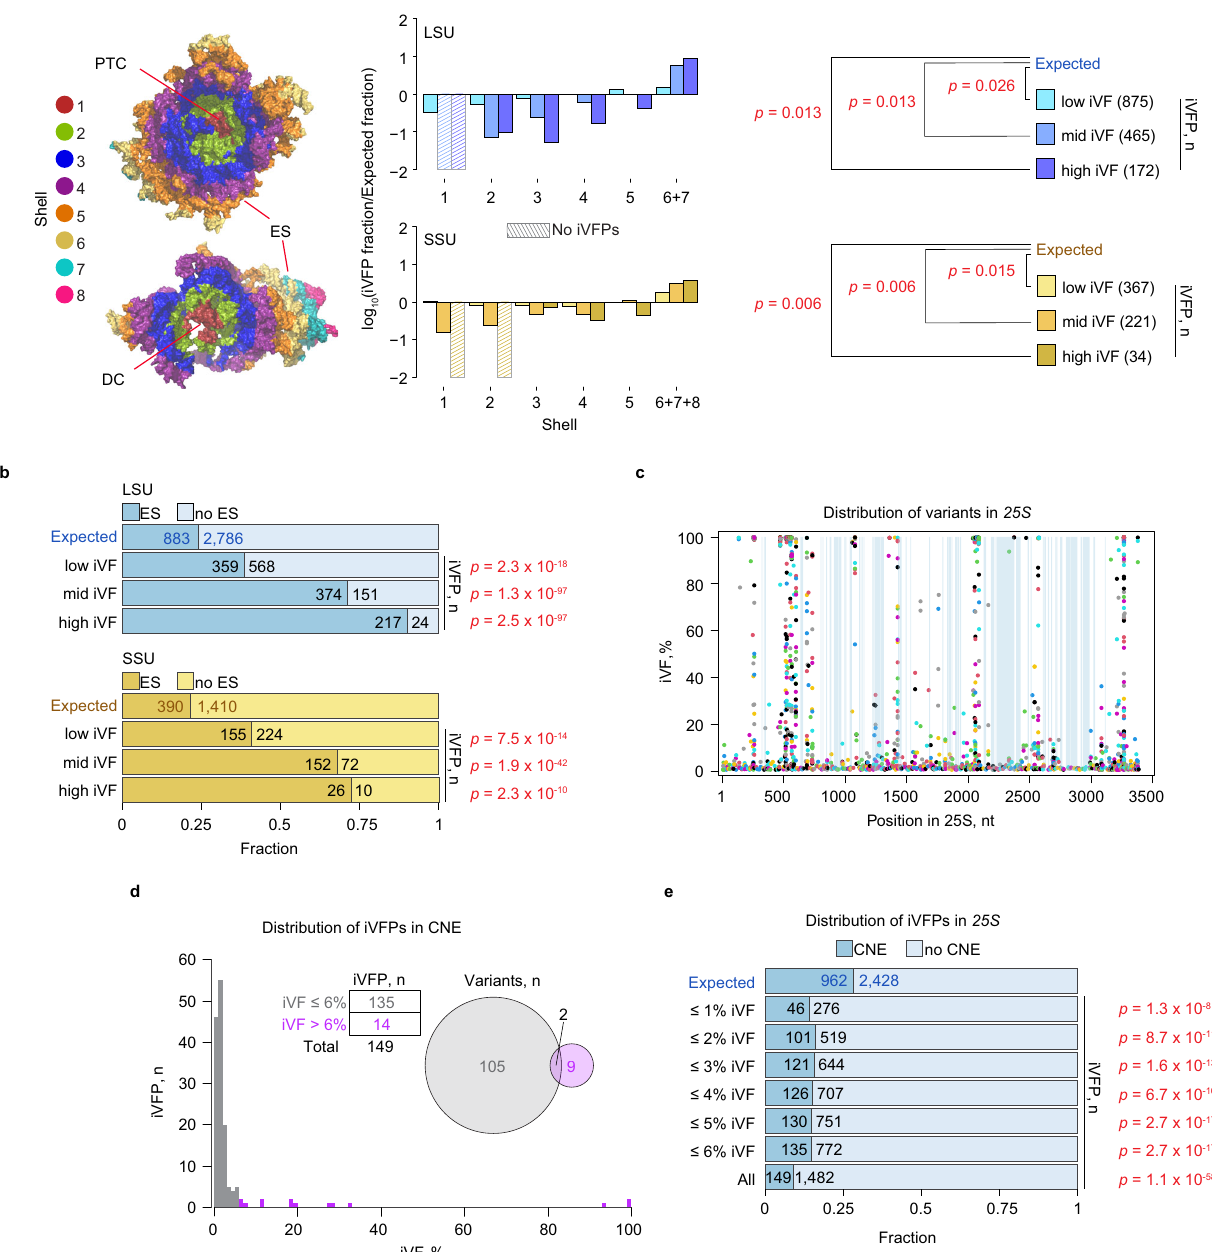
Fig. 5 | Selectionpro fi leoftheyeast 80S ribosome.a Distribution of the number of low, medium, and high iVFPs observed (numbers are indicated in brackets) versus expected in both the LSU and the SSU across their respective concentric shells (see text; depicted to the left). The outermost shells in the LSU and the SSU werepooledtogetherduetothelownumberofnucleotides.Shells1intheLSUand 1 and2in the SSU didnot have anyvariants and their log values were arti fi ciallyset to − 2 (hashed bars). Red lines point to the location of: PTC — peptidyltransferase center; DC — decoding center; and ES — expansion segments. b Distribution of iVFPs between expansion segments ( “ ES ” ) and other parts of the rRNA ( “ no ES ” ). c Distribution of variants across eukaryotic conserved nucleotide elements (CNEs, highlighted in blue). d Distribution of iVFPs that are detected in the CNEs. Inset —